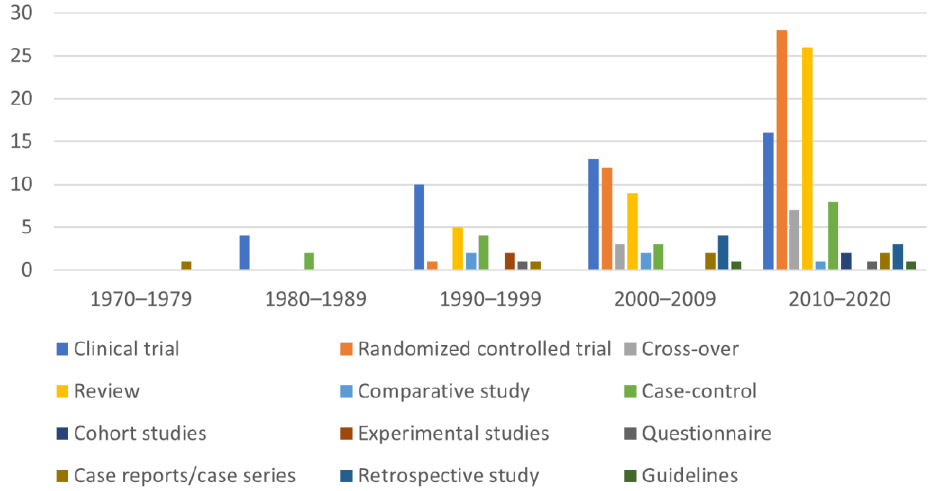
Figure 4. Subdivision of the studies published in veterinary medicine journals (DMD and DNAD) according to the type of study in the five decades taken into consideration. It is interesting to note that in the last decades the typologies of veterinary medicine studies were more diversified than in the last century.